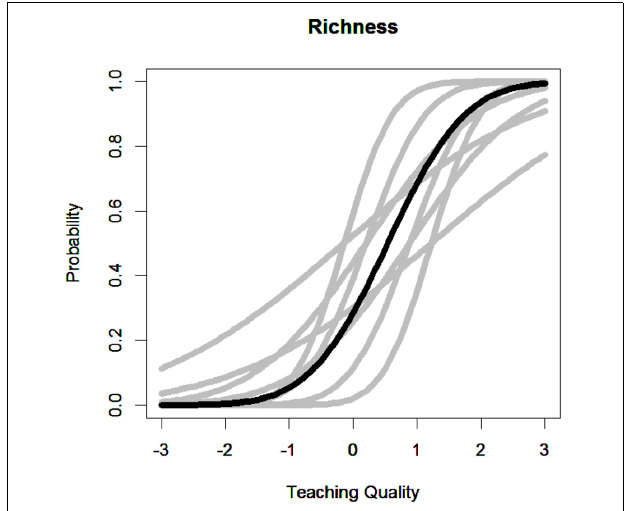
FIGURE 1 | Item characteristic curve for a single item across different raters.